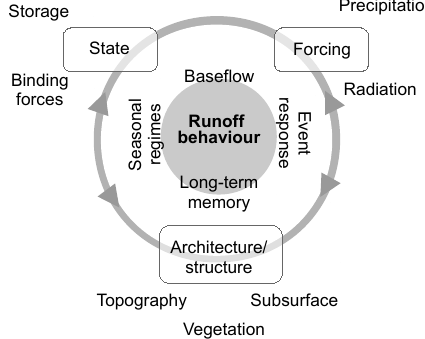
Figure 1. Conceptual sketch of the major temporal scales of runoff formation, i.e. long-term behaviour, seasonal regimes, generation of baseflow and event runoff production, and corresponding first-order